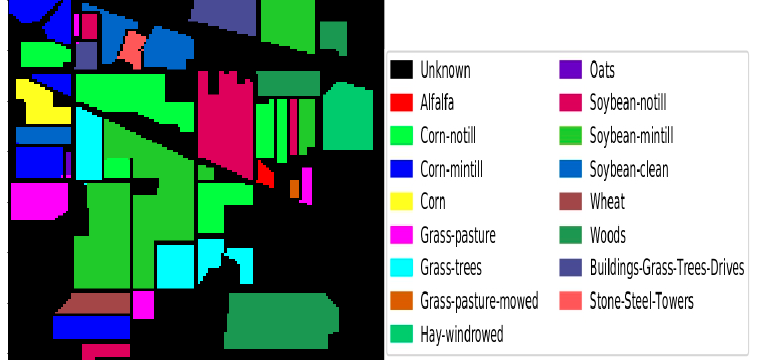
Figure 4. Indian Pines dataset with colour codes. Table 1. Training and test samples of Indian Pines dataset .